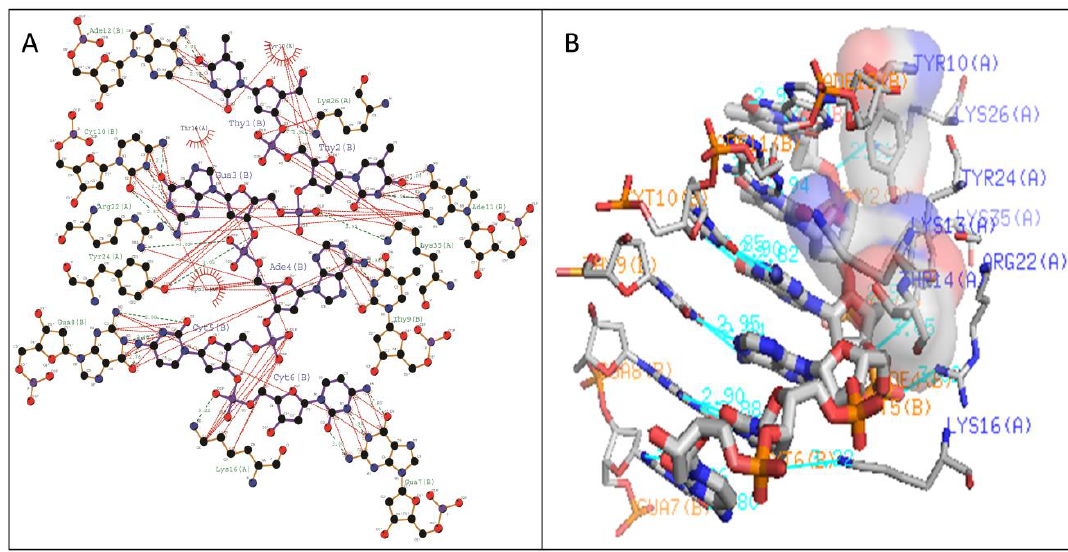
Figure 8. Illustration of ( A ) 2-dimensional and ( B ) three-dimensional representation of the Type II WRKY protein DNA docked complex. Hydrogen bond interaction of DNA with WRKY protein amino acid residues, Arg10, Lys15, and Lys32 (shown by the green line) whereas residues Arg12, Gly14, Lys24, and Arg28 interacts through hydrophobic bonding (shown in red lines).